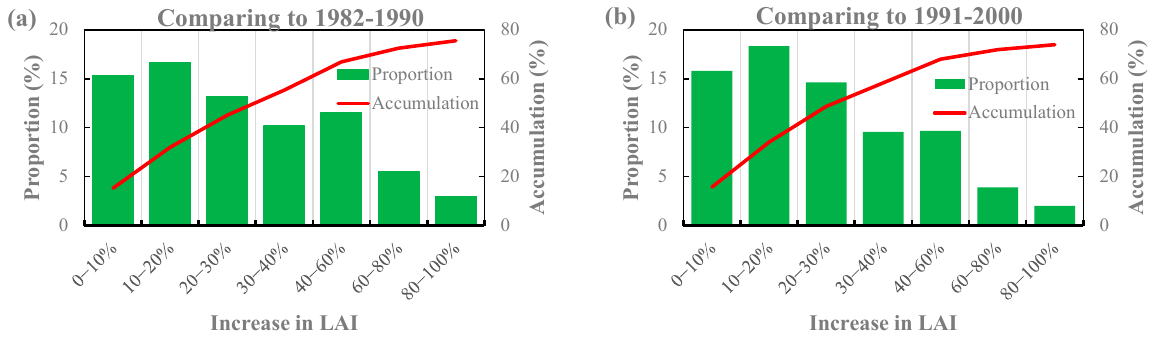
Figure 6. The statistics of greening of NDPB for 2001–2011 relative to 1982–1990 ( a ) and 1991–2000 ( b ). Proportion stands for the percentages of different increase ranges of ET, while accumulation is for the accumulation of these percentages.